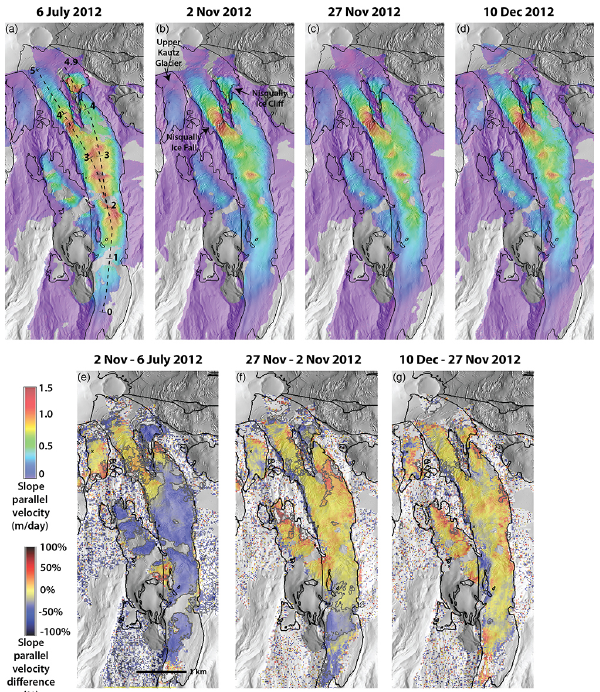
Figure 4. (a–d) Median slope-parallel velocities for Nisqually and Wilson glaciers for four different time periods taken from ROI view- point. Dashed lines on top left panel show locations of profiles taken to create Fig. 6, markers indicate distance in kilometers. (e–g) Per- cent change in median slope-parallel velocity for the Nisqually and Wilson glaciers between time periods. Blue indicates a velocity de- crease and red indicates a velocity increase relative to the earlier time period; gray polygons indicate areas where velocity change is significant with 95% confidence. Area shown is indicated by Box B on Fig. 1.